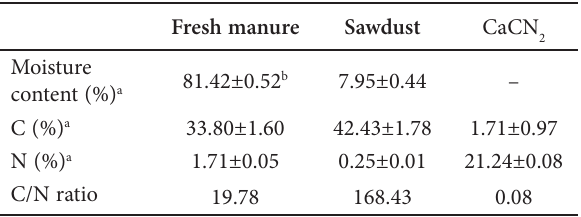
Table 1. Characteristics of composting